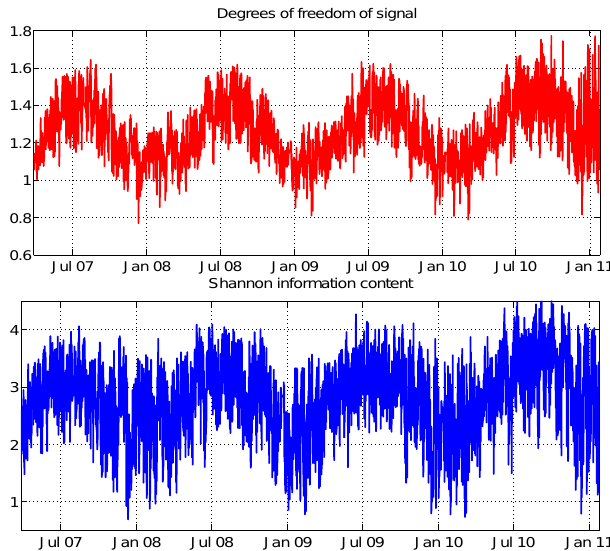
Fig. 11. Degrees of freedom and Shannon information content (bits) for retrievals of spectra averaged over four hours. Clearly visible is the annual cycle. Further it seems, that the increase of the num- ber of tipping calibrations in April 2010 has slightly increased the information content and the degree of freedom of the retrievals.